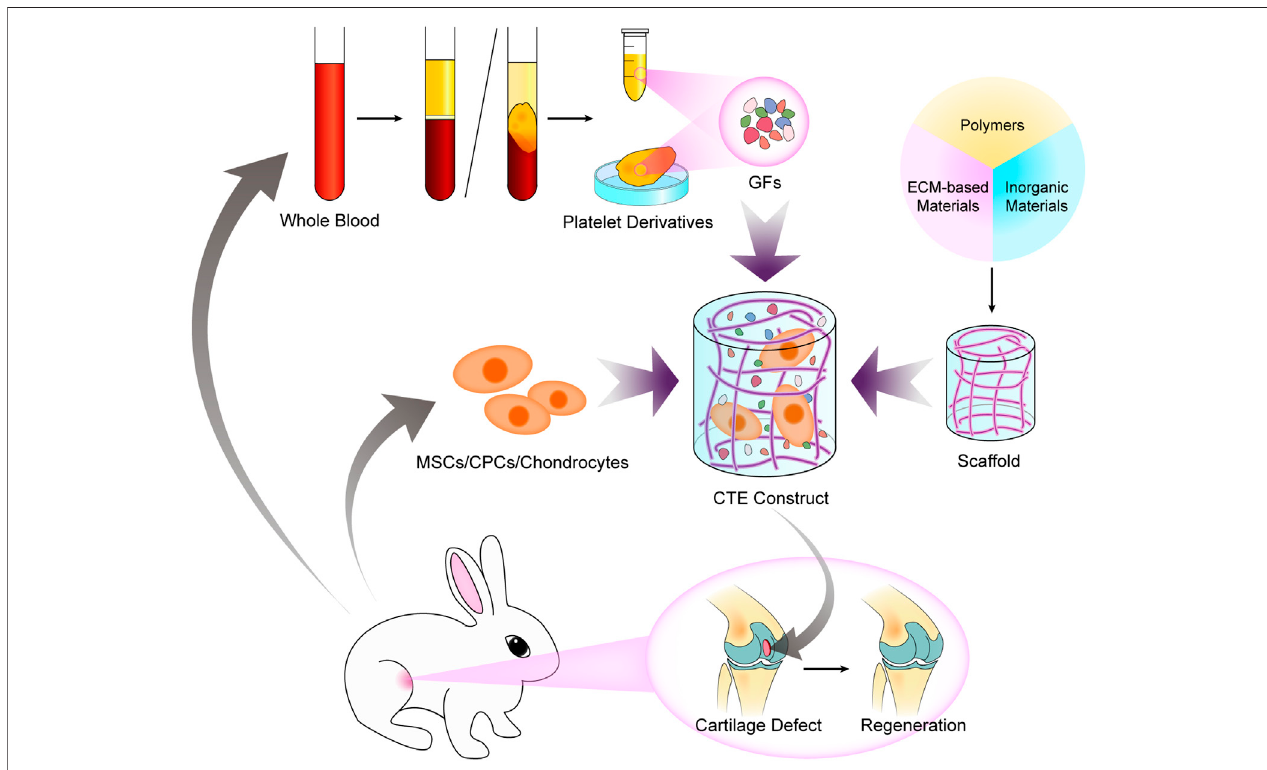
SCHEME 1 | Fabrication of a CTE construct with autologous platelet derivatives, seed cells, and a scaffold for improved regeneration of articular cartilage defects.